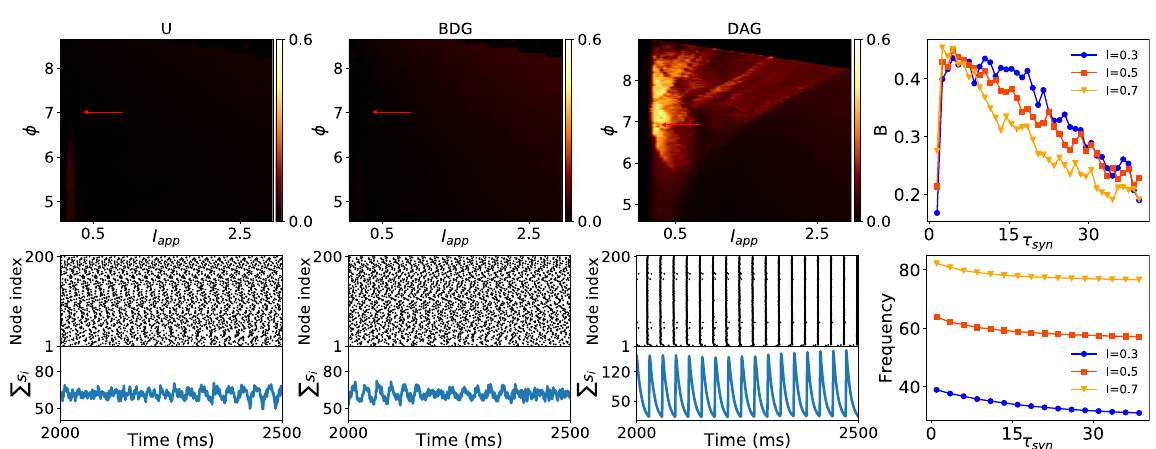
Figure 5. Comparison of synchronization of type I excitatory phase oscillators on excitatory scale-free DAGs with different exponents. (First Column) The degree distribution of the scale-free networks with different scaling exponents, 1024 nodes and average degree of 10. Dashed lines represent linear curve fittings to the probability distribution functions. (Second Column) The stationary order parameters of scale-free DAGs versus scaling exponents, for = K 3 . (Third and fourth Columns) display the average clustering coefficient ( C ) of the undirected backbones and the average shortest path from the source node to other nodes ( S ), versus the scaling exponents. The results are averaged over 50 realizations.